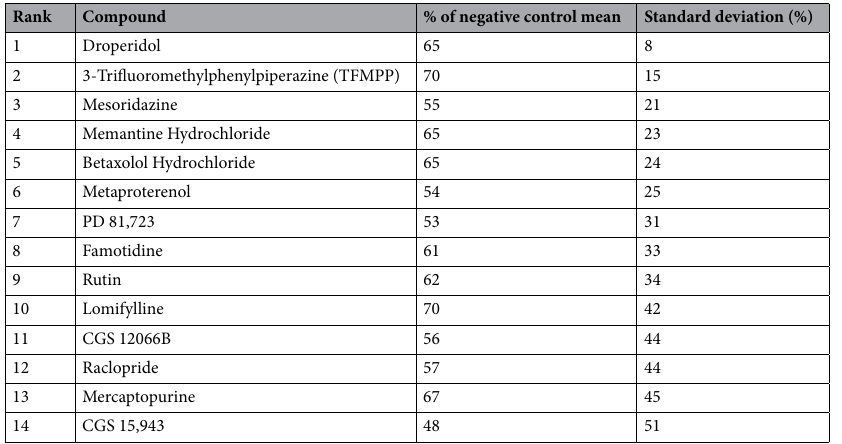
Table 1. The 14 hit compounds from a screen of the NIHCCLI&II libraries for angiogenesis inhibitors. The library was screened three times. Compounds were considered hits if they reduced the endothelial network by 30% or more on average when compared to the average of the negative control endothelial network. More value was given to consistency; therefore, the compounds were ranked according to the standard deviation between the three